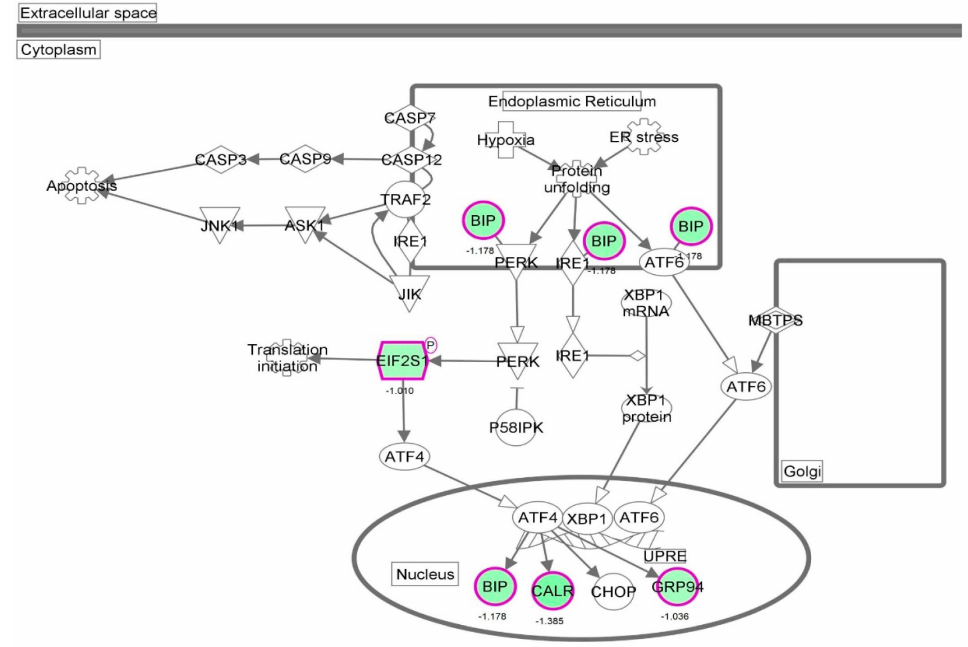
Figure 36. ER stress signaling pathway was regulated by vancomycin in HK-2 cells. HK-2 cells were treated with 50 µ g/mL vancomycin for 24 h and the protein samples were subject to quantitative proteomic analysis. Green indicates a down-regulation. The intensity of green color indicates the degree of down-regulation. Solid arrow indicates direct interaction.